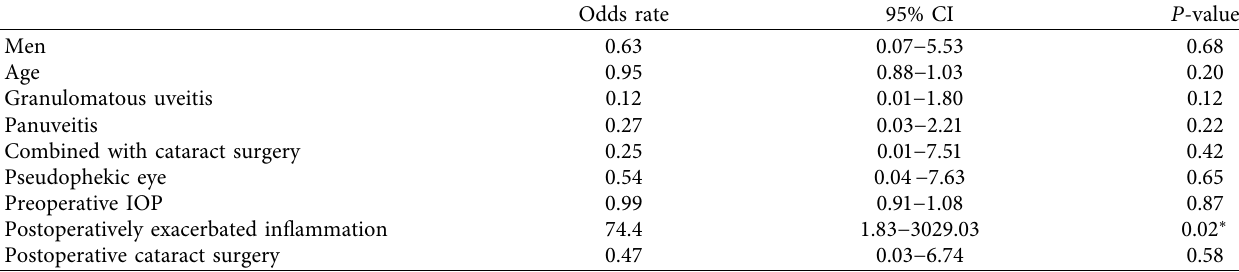
Table 5: Multivariate logistic regression analysis of the risk factors for surgical failure at 3 years in UG. Odds rate 95% CI